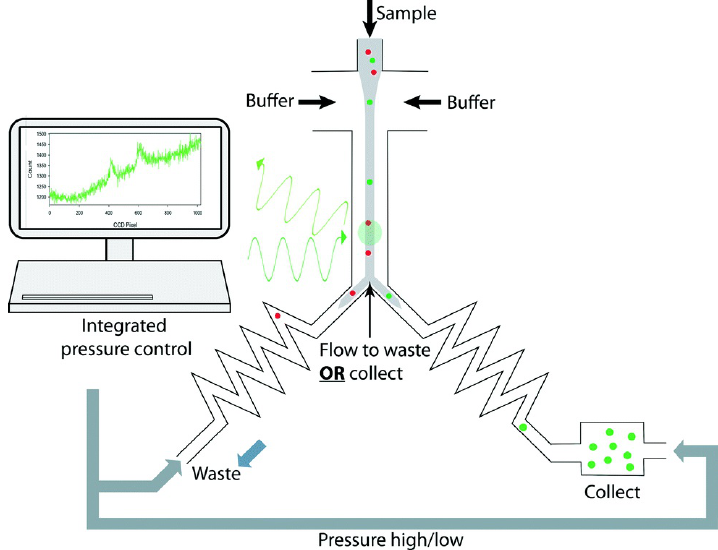
Figure 8. Schematic representation of the proposed device. A stream of cells were hydrodynamically focused in the detection channel for continuous Raman acquisition; on-the-fly classification was carried out to identify target cells and was immediately followed by alternating the pressures applied to the waste and collection channels, to direct the target cells to the collection chamber. Integrated software was developed to synchronise and automate all the operations. Reprinted with permission from [111]. Copyright 2016, Royal Society of